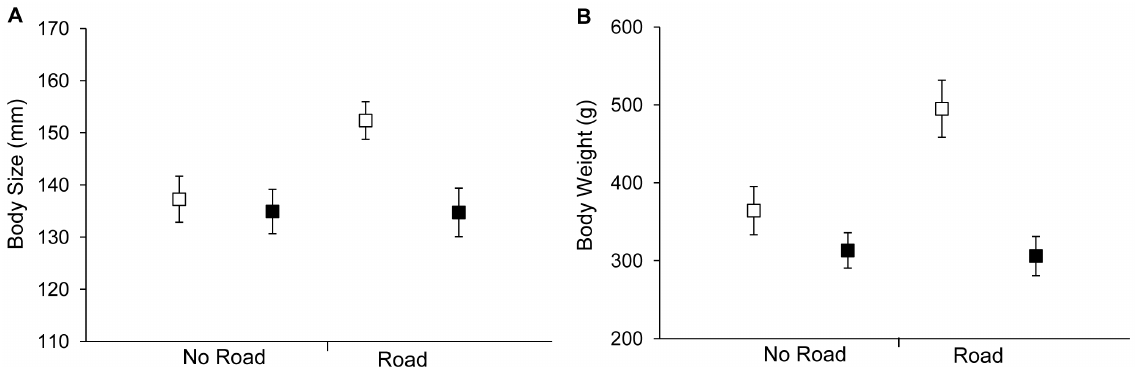
Figure 6. Carapace length and body weight of captured turtles. Panel (A) shows mean body size of captured females ( % ) and males ( & ), measured as straight line carapace length in mm, at No Road and Road sites. Panel (B) shows mean body weight in g of captured females ( % ) and males ( & ), at No Road and Road sites.